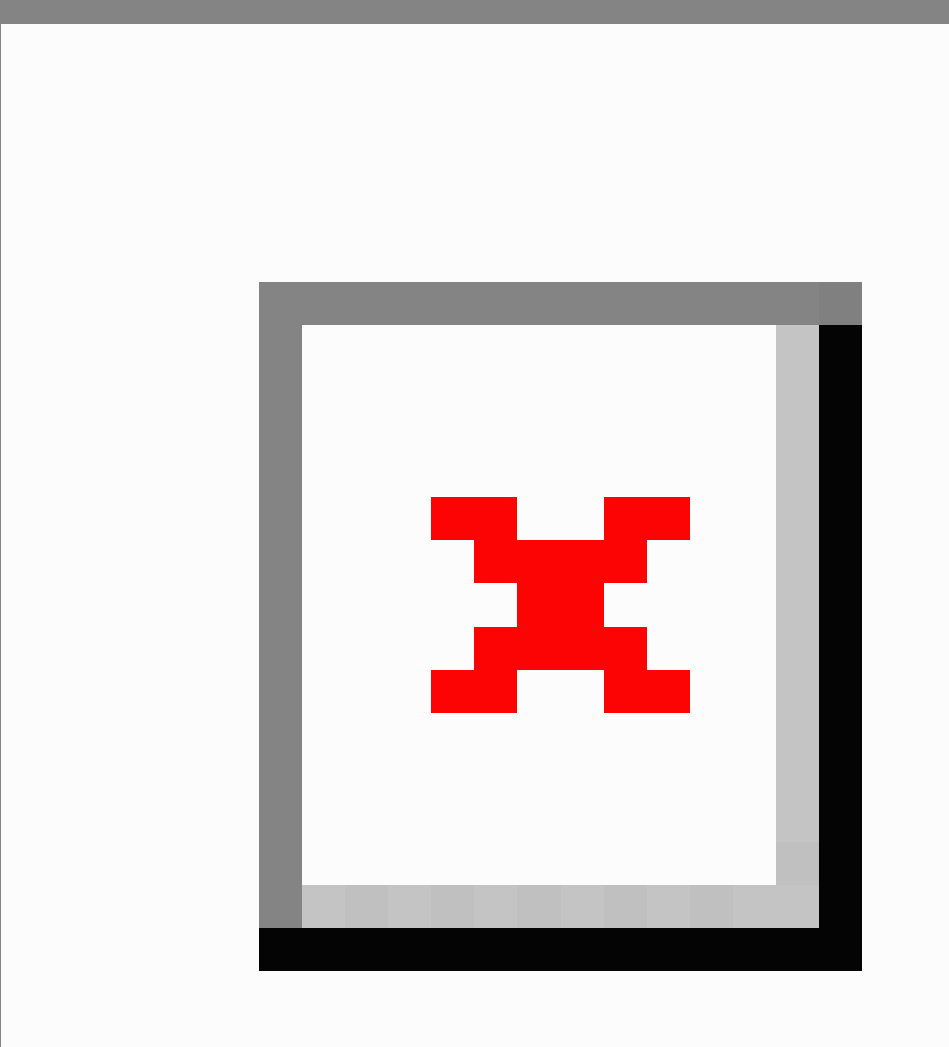
Figure 2. Mean AGREE II domain scores for the 7 eligible clinical practice guidelines. NCPIC: National Cannabis Prevention and Information Centre; IPS: Indian Psychiatric Society; NICE: National Institute for Health and Clinical Excellence; APA: American Psychiatric Association; NSWD: New South Wales-Drug; NSWP: New South Wales-Pregnancy; and NHC: National Health